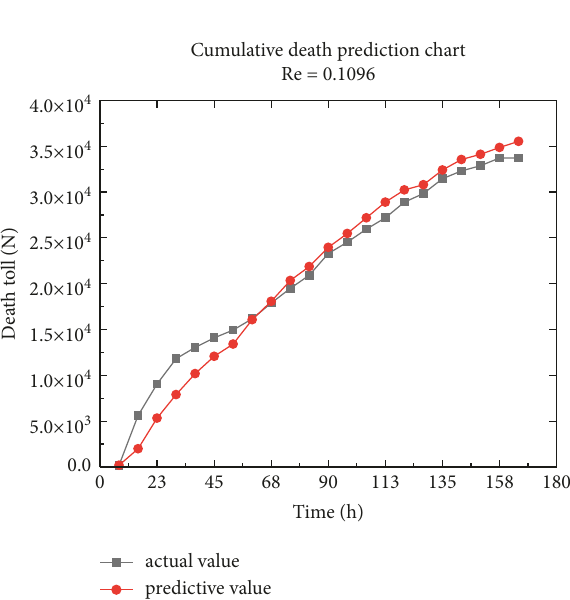
Figure 8: Comparison between predicted and real values of cumulative